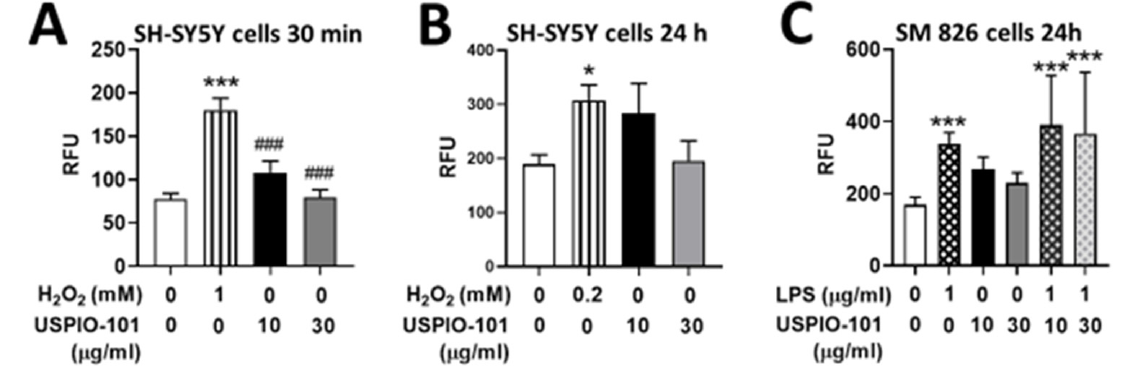
Figure 5. Intracellular reactive oxygen species level after treatment with USPIO-101 in SH-SY5Y or SM826 cells. ( A , B ) Hydrogen peroxide (H 2 O 2 ) as positive control and USPIO-101 (10 or 30 µg/mL) were used in SH-SY5Y cells for 30 min ( A , H 2 O 2 1 mM) and 24 h ( B , H 2 O 2 0.2 mM), respectively. ( C ) Lipopolysaccharide (LPS) 1 µg/mL as positive control and USPIO-101 (10 or 30 µg/mL) were used in SM826 cells for 24 h, respectively. RFU means the relative fluorescence unit in 3 × 10 4 cells/well in 96-well plates. Data shown are the mean ± SEM of three independent experiments performed in triplicate. * or ***: p < 0.05 or p < 0.001 vs. control group. ###: p < 0.001 vs. the H 2 O 2 group (one-way ANOVA).